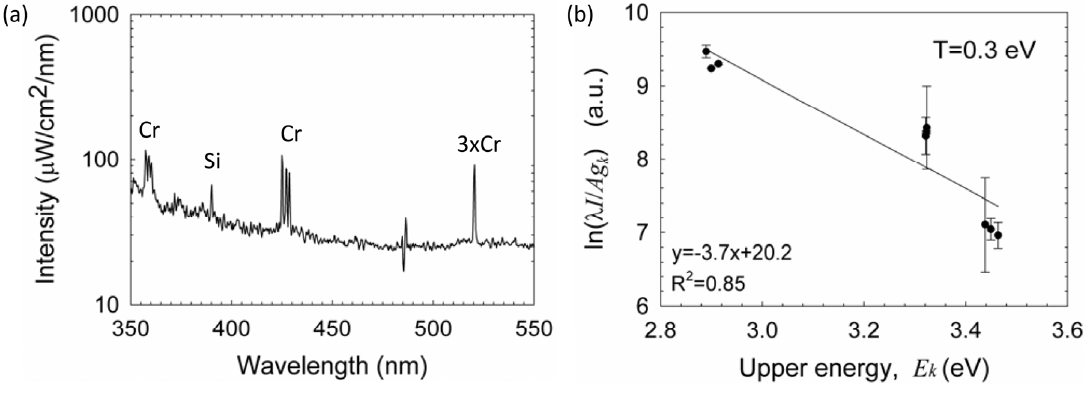
Figure 7. ( a ) An emission spectrum of silicon lines with chromium impurities; and ( b ) a Boltzmann-plot fit of the chromium lines resulting in ~0.3 eV excitation temperature. (Note a diode line defect at 485 nm in Figure